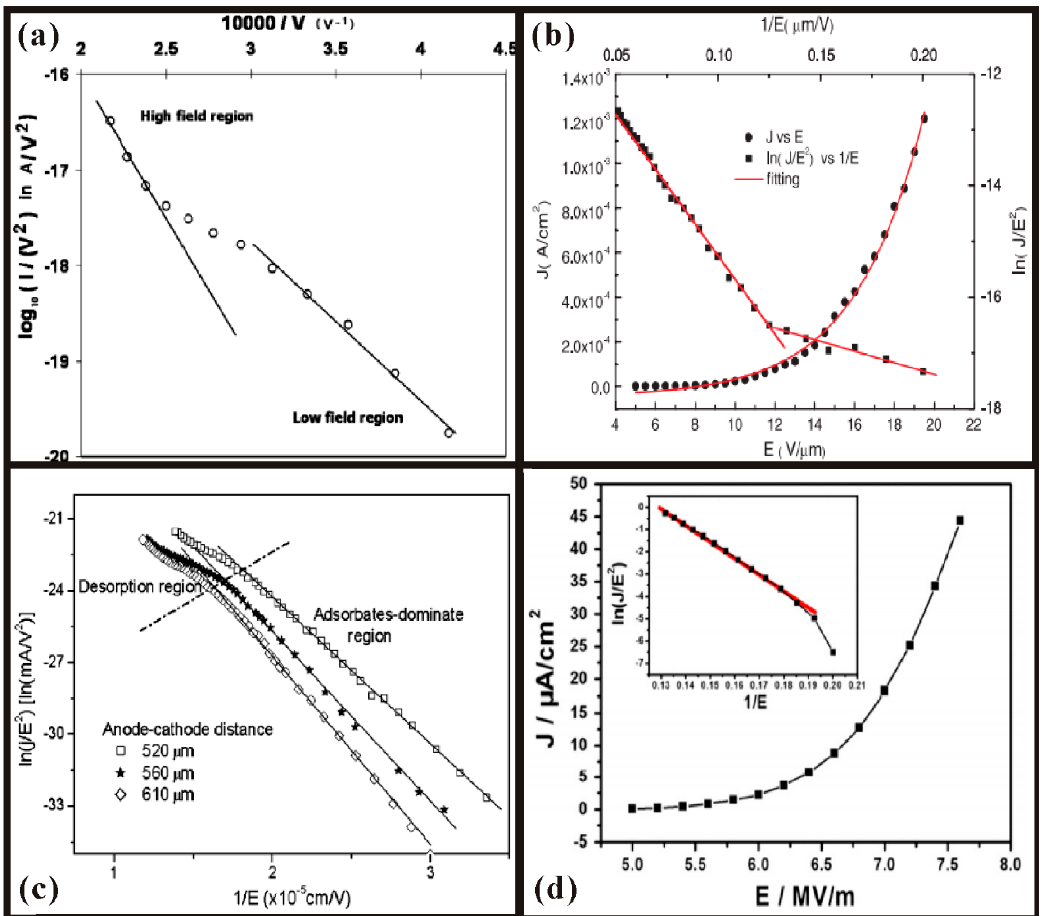
Figure 15. Some non-linear ( a – c ) and typical linear ( d ) Fowler–Nordheim (FN) plots in the field emission of ZnO nanowires. ( a ) Reproduced from [73], with the permission of ACS Publications, 2010. ( b ) Reproduced from [74], with the permission of IOP Publishing, 2007. ( c ) Reproduced from [75], with the permission of AIP Publishing, 2004. ( d ) Reproduced from [70], with the permission of IOP Publishing, 2014.